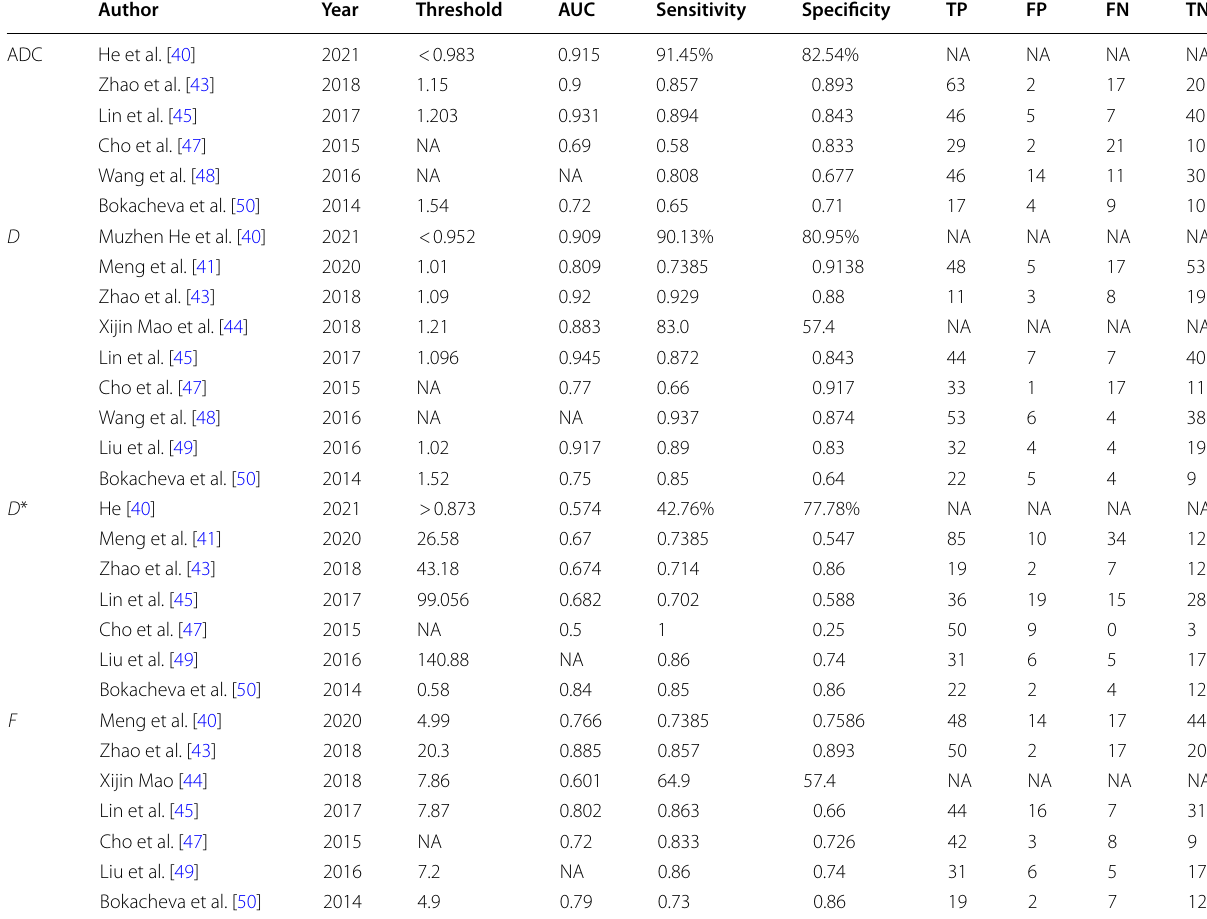
Table 3 The estimated sensitivity and specificity in the included studies in the current meta-analysis